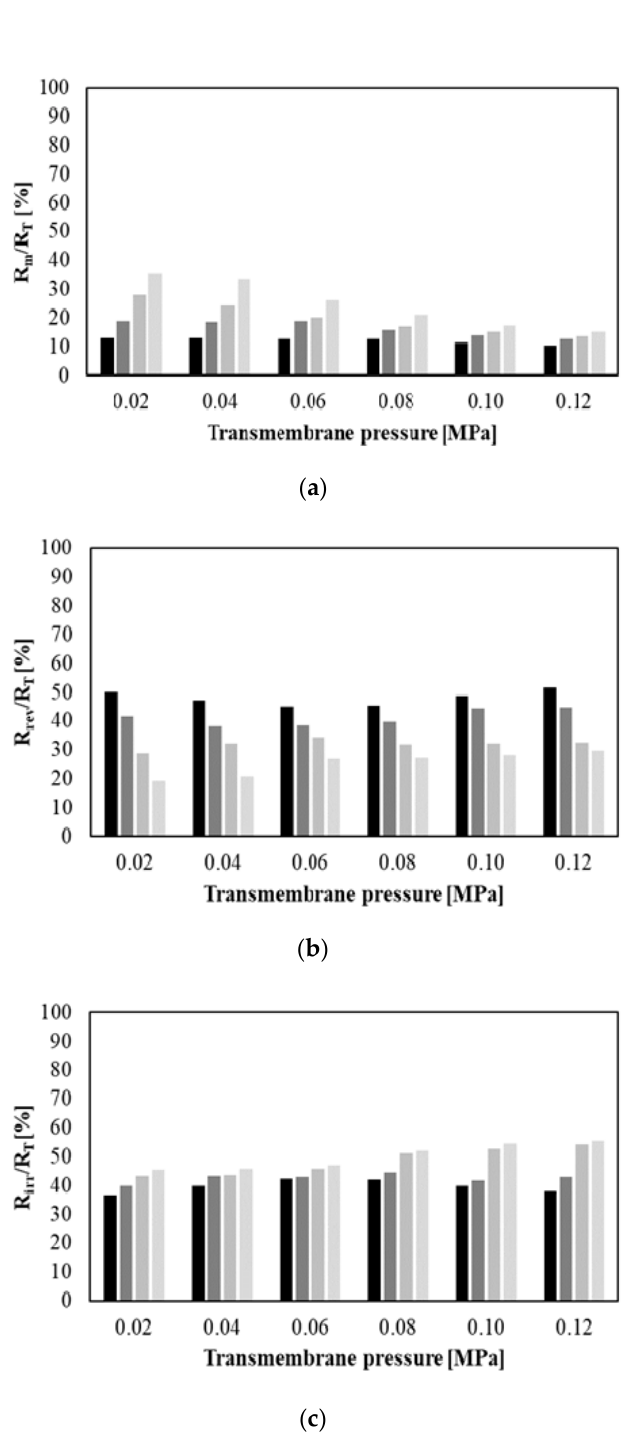
Figure 8. Hydraulic resistance percentages as a function of transmembrane pressure and feed flow rate. ( a ) Membrane resistance; ( b ) reversible fouling resistance; and ( c ) irreversible fouling resistance.